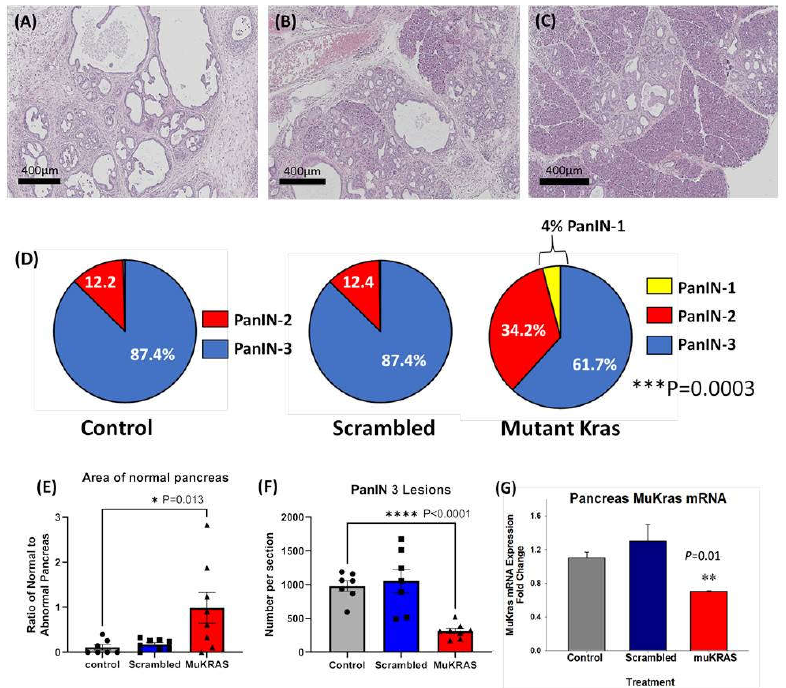
Figure 1. CCK-BR targeted NP loaded with siRNA for muKras decreases the number of high grade PanIN lesions in P48-Cre/LSL-Kras G12D mice. ( A ) H&E stain of a representative 6 month-old control mouse pancreas revealed extensive high grade PanIN lesions and fibrosis replacing the pancreas. ( B ) A representative image of a pancreas from a 6-month old P48-Cre/LSL-Kras G12D mouse treated with the NP loaded with the scram- bled siRNA also shows high grade PanINs and fibrosis. ( C ) A representative H&E stain of a 6 month pan- creas of a P48-Cre/LSL-Kras G12D mouse after 14 weeks of therapy with the target specific NP loaded with muKras siRNA shows fewer PanINs and preservation of the normal pancreas histology. ( D ) Pie-shaped di- agrams from the three treatment groups shows that 87.4% of the PanINs counted were high grade PanIN-3 lesions in the pancreas of control and scrambled siRNA-treated P48-Cre/LSL-Kras G12D mice. The number of high grade PanINs are less and the low grade PanINs increased in mice treated with the NP delivering the muKras siRNA. This difference was significant ( p = 0.0003). ( E ) The ratio of normal pancreas area to abnormal pancreas was greater in the pancreas of mice treated with the muKras siRNA ( p = 0.013). ( F ) The absolute number of PanIN-3 lesions per histologic section is shown with significantly less PanIN-3 lesions in the pancreas of the muKras siRNA-treated mice ( p < 0.0001). ( G ) mRNA expression of muKras was decreased in the pancreas of mice treated with the NP carrying the muKras siRNA payload ( p = 0.01). * p < 0.05; ** p < 0.01; *** p < 0.005; **** p < 0.0001. Individual data points are represented by circles, squares and triangles in the columns. 2.2. Targeted NPs Loaded with mutant Kras siRNA Decrease Fibrosis in the Pancreas Extracellular Matrix During pancreatic carcinogenesis, the normal parenchyma of the pancreas is re- placed with the precancerous PanIN lesions and dense fibrosis in the pancreatic extra- cellular matrix (ECM) or tumor microenvironment (TME). This characteristic desmo- plastic reaction found in the pancreas of the KC mice and also in human pancreatic can- cer is due to the activation of pancreatic stellate cells and fibroblasts [30]. The pancreas from control KC mice (Figure 2A) and from the KC mice treated with CCK-BR targeted NPs loaded with a scrambled siRNA (Figure 2B) exhibited marked intra-pancreatic fi- brosis as shown in the representative images of sections stained with Masson’s trichrome. KC mice treated for 4 months with targeted NPs loaded with muKras siRNA not only had fewer high grade PanIN lesions and preservation of pancreatic acinar cells, but also ex-